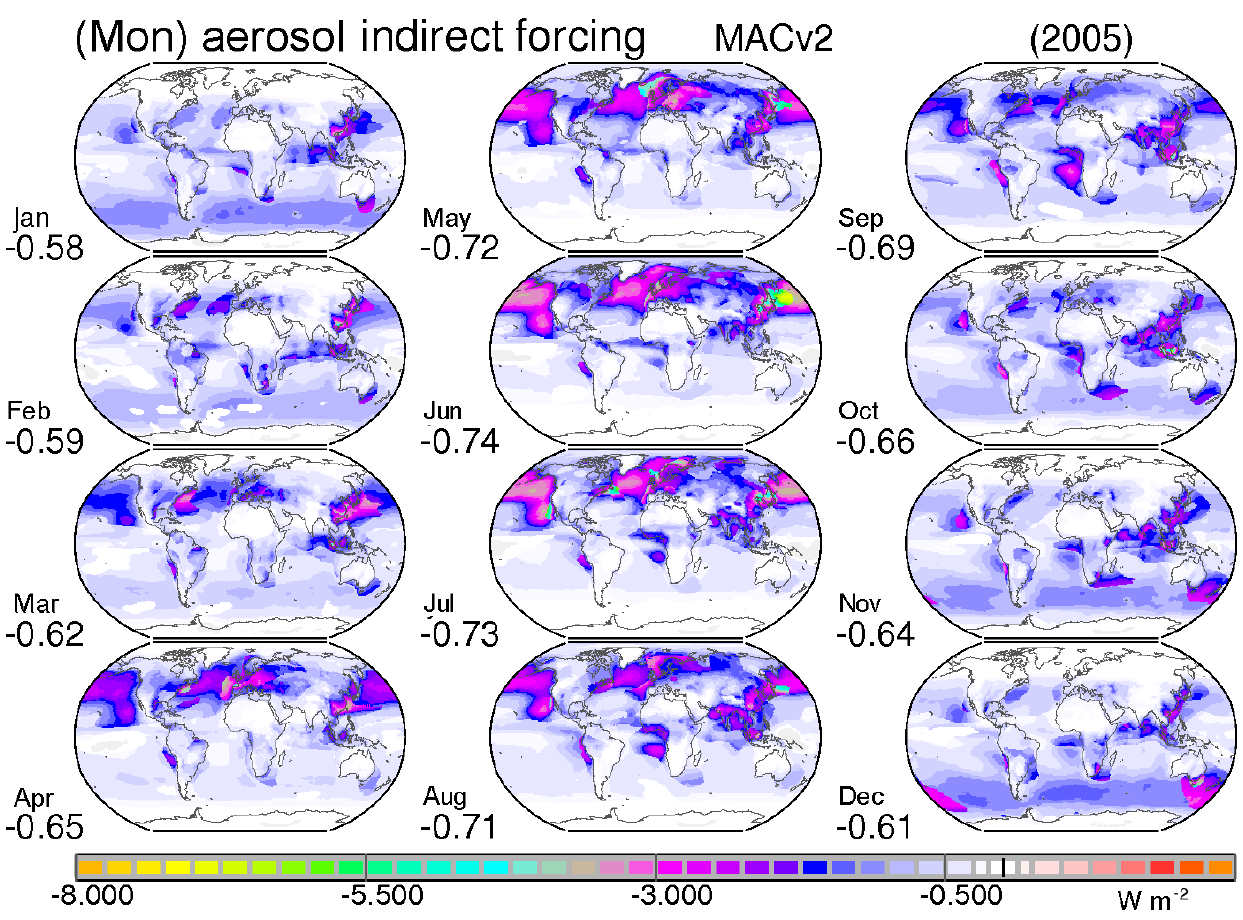
Figure 13. Monthly maps for today’s indirect (Twomey) forcing by present-day anthropogenic aerosol.